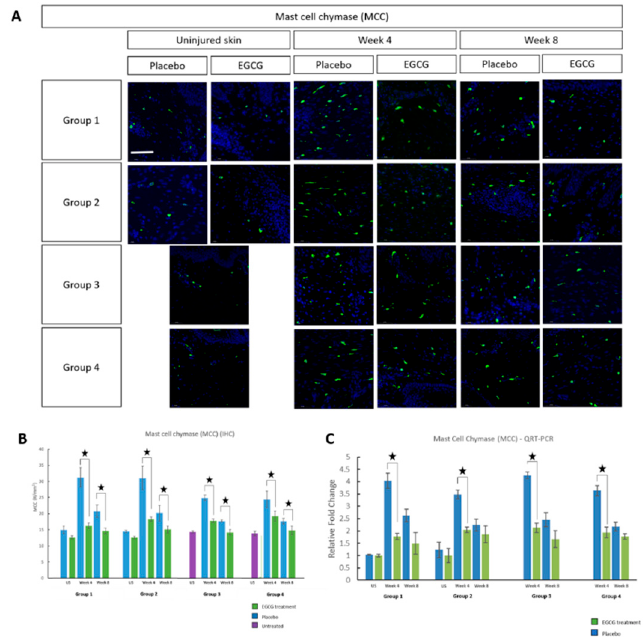
Figure 5. Mast cell chymase (MCC) analysis of topical epigallocatechin-3-gallate (EGCG) versus placebo. ( A ) MCC images show a reduction at weeks 4 and 8 in EGCG samples compared to placebo in all groups. ( B ) MCC measurements (#/mm2) showed EGCG samples were significantly lower compared to placebo at weeks 4 and 8 ( p < 0.01) in all groups. Between groups there were significant differences at week 4 (Anova p = 0.001). Group 1 had a greater difference than Group 3 ( p = 0.01) and Group 4 ( p = 0.001), and Group 2 had a larger difference than Group 4 ( p = 0.009). ( C ) Subsequent QRT-PCR analysis confirmed down-regulation of MCC ( p < 0.05) in EGCG samples compared to placebo at week 4 in all groups. Significance: ★ p ≤ 0.01. Error bars: mean ± SD. Scale bars = 50 μ m. (DAPI = blue, MCC = green). Pharmaceutics 2021 , 13 , x.